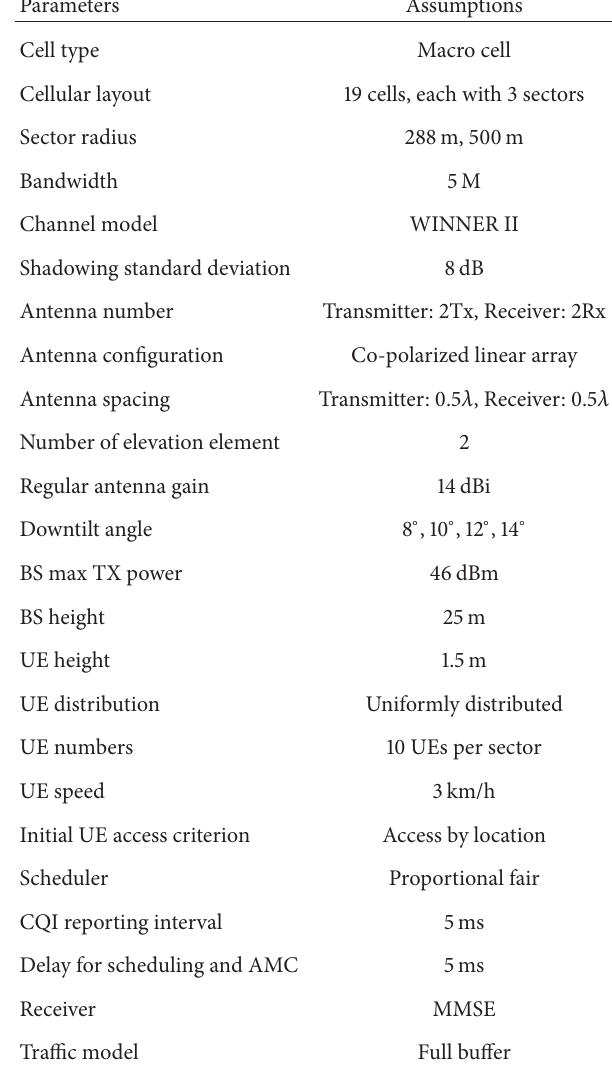
Table 1: Simulation configuration